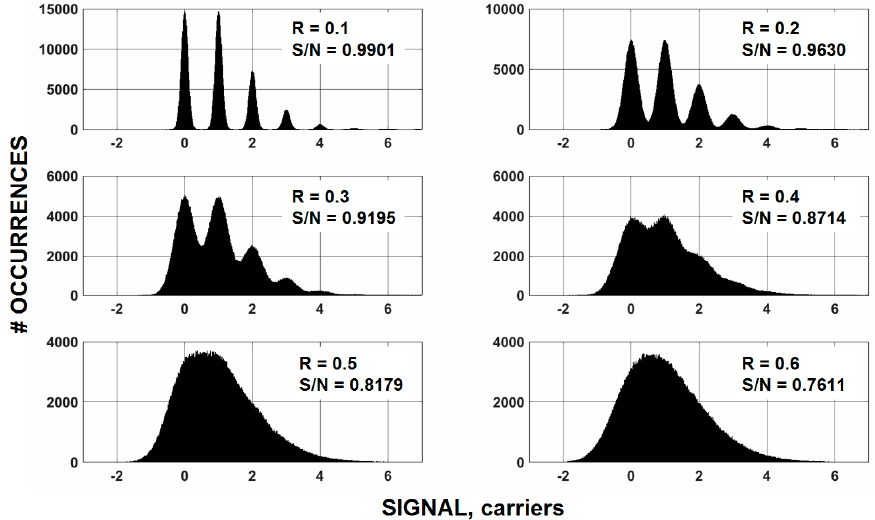
Figure 4. Simulated histograms for an average signal level of “one” carrier and six different read noise (R) levels. The histogram shows that a read noise <0.3 carriers rms is required for precise photon counting results.